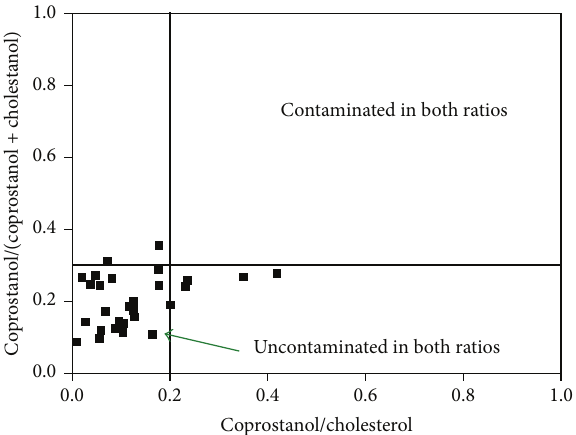
Figure 4: Plot of coprostanol/(coprostanol + cholestanol) ratios against coprostanol/cholesterol ratios for all sedimentary core sam- ples that presented quantifiable concentration of these sterols. The lines inside the graph represent the regions that are considered contaminated or uncontaminated by the diagnostic